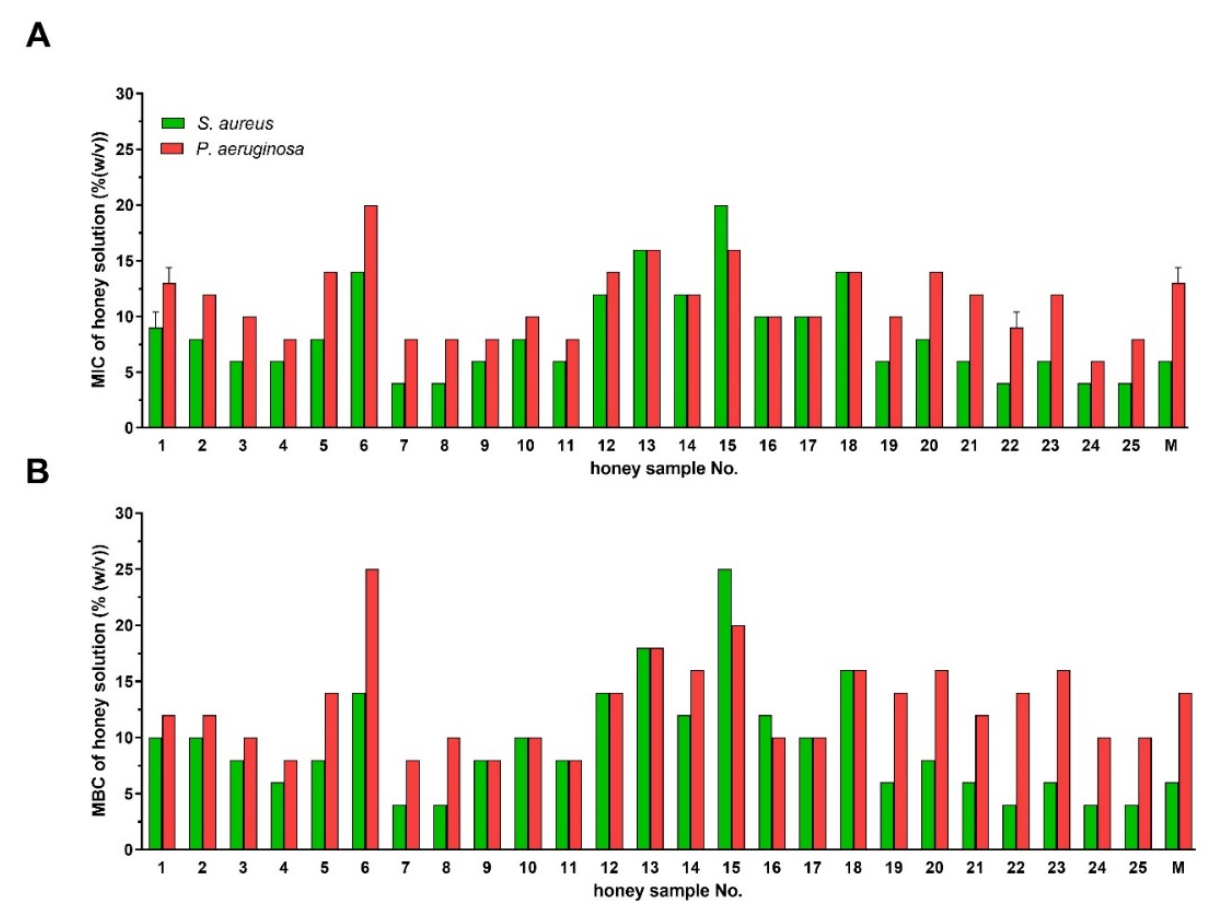
Figure 1. Antibacterial activity of Styrian honey samples ( n = 25) and manuka honey UMF 15+ (M) against Staphylococcus aureus and Pseudomonas aeruginosa isolates. Activity was determined with a minimum inhibitory concentration (MIC) ( A ) and a minimum bactericidal concentration (MBC) assay ( B ). MIC and MBC were defined as the lowest concentrations of honey solution (%) inhibiting bacterial growth and killing the bacteria, respectively. Data are expressed as the mean values with SD.